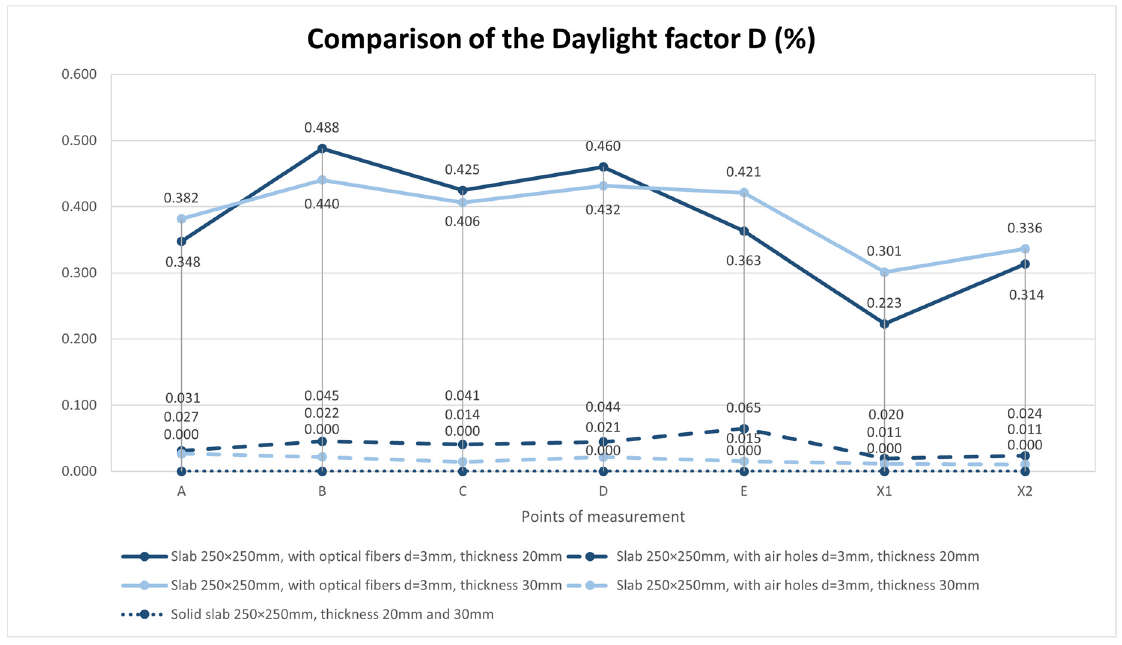
Figure 27. Comparison of the daylight factor D (%).